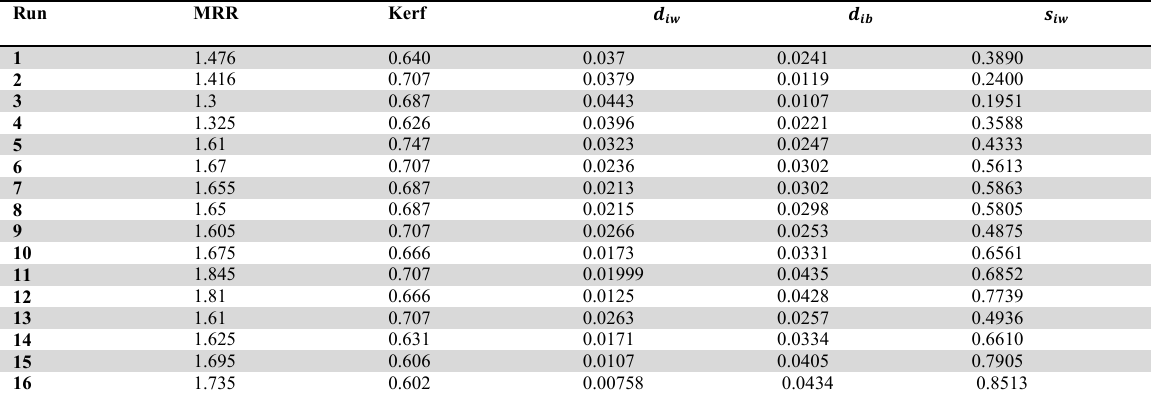
Multi-objective Optimization using TOPSIS